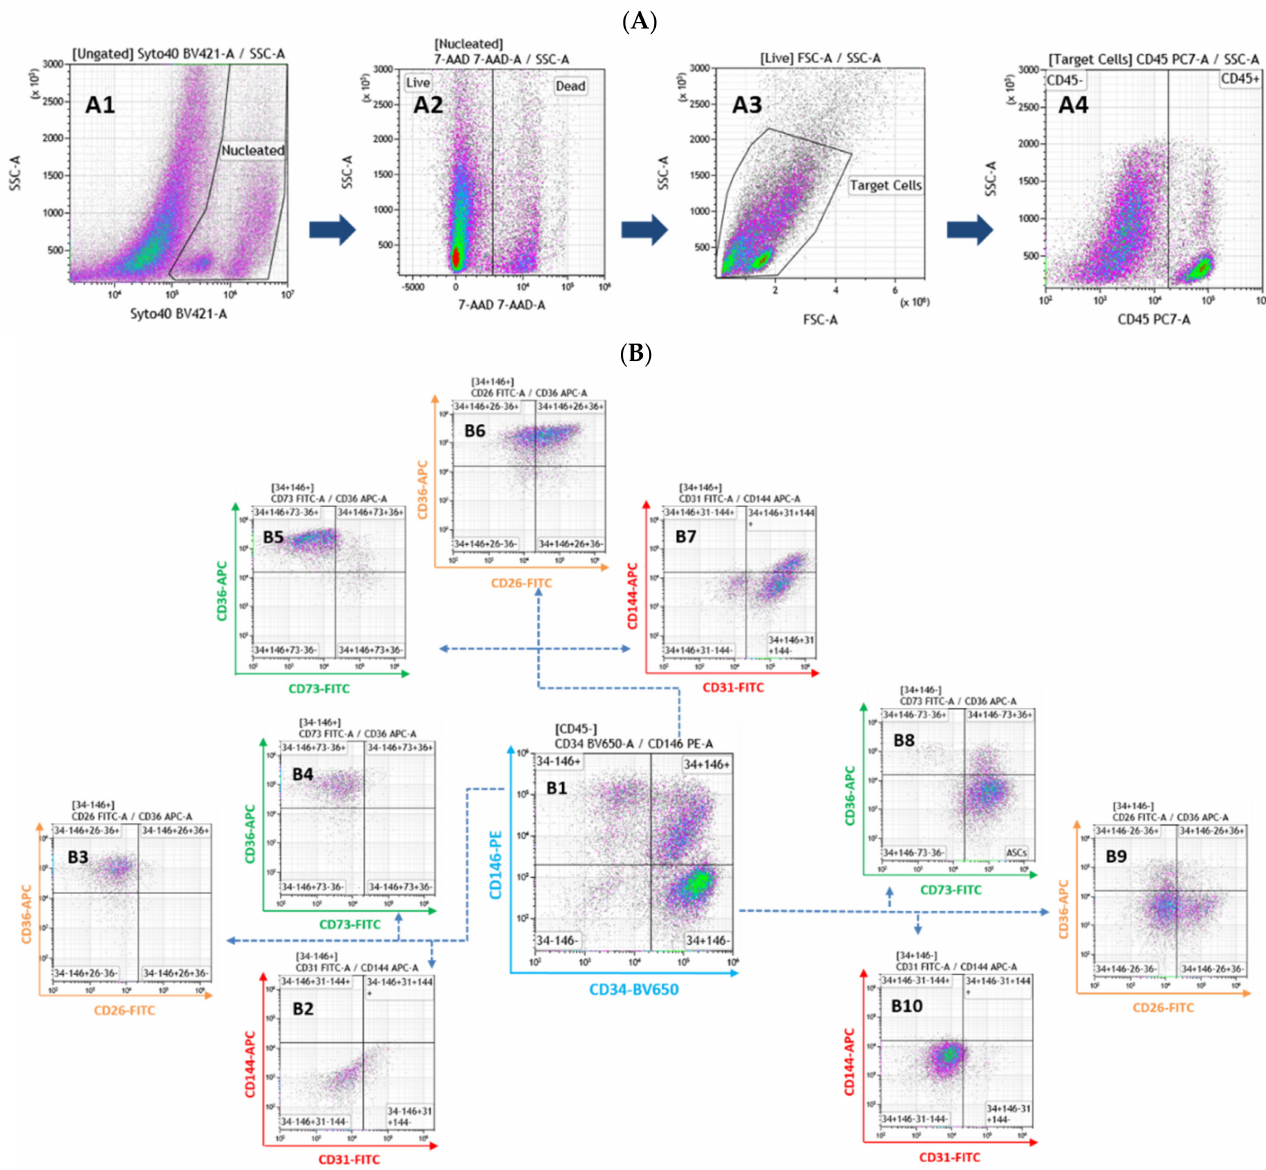
Figure 1. Representative flow cytometry analysis of stromal vascular fraction (SVF) cells based on our seven-color staining procedure. ( A ) The gating strategy used to find viable target cells is shown. Syto 40 marks all nucleated cells, and 7-AAD discriminates between living and dead (plot A1 and A2 , respectively). In the next two gates (plot A3 and A4 , respectively), we selected cells that are relatively small and CD45 − . ( B ) Representative analysis of the SVF cells extracted from human subcutaneous adipose tissue. CD45 − target cells were first analyzed for the expression of CD34-BV650 and CD146-PE. This leads to four sub-populations of cells (plot B1 ). Except for the lower left quadrant of plot B1, the cells present in the three other quadrants were further investigated for the expression of three pairs of new markers: (1) CD31-FITC/CD144-APC (plots B2 , B7 , & B10 ). (2) CD26-FITC/CD36-APC (plots B3 , B6 , B9 ). (3) CD73-FITC/CD36-APC (plots B4 , B5 , B8 ). Data in A and B are from a representative patient. See the Supplementary Information (S2: Characterization of the cells of the SVF from adipose tissue and Table S2) for more details about the markers used for this flow cytometry